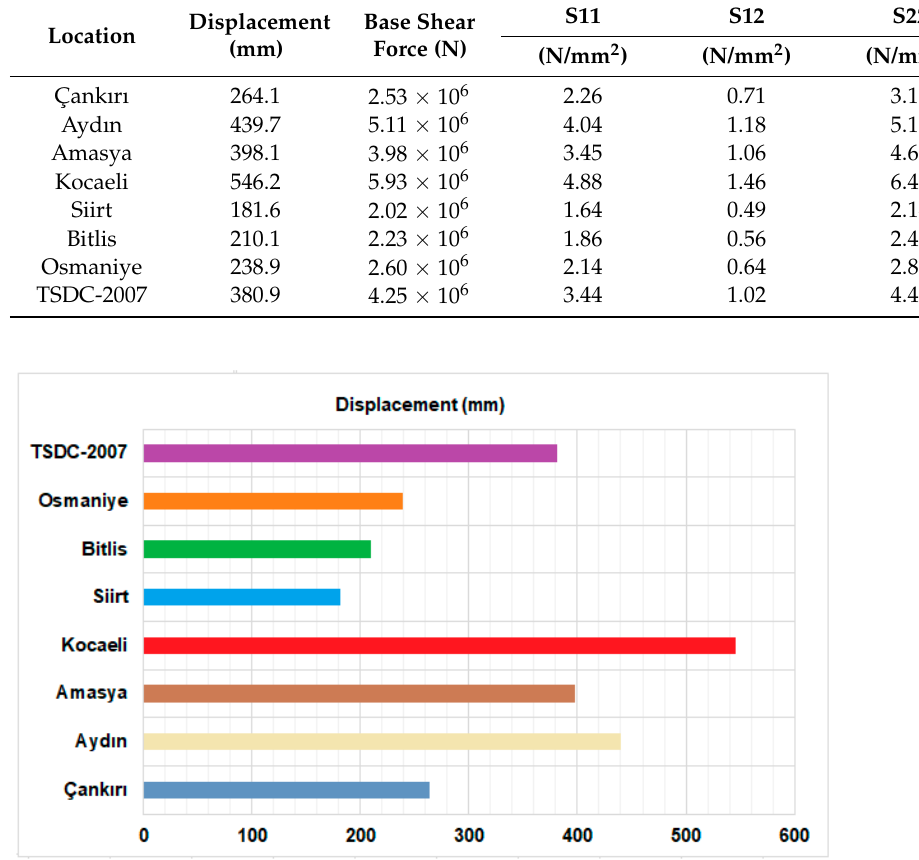
Figure 30. Comparison of displacement values for each settlement.